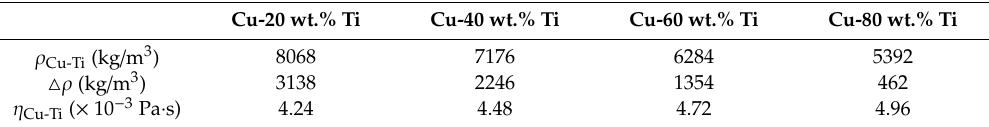
Table 1. The values of ρ Cu-Ti , (cid:52) ρ , and η Cu-Ti with di ff erent Cu-Ti proportions (e.g., “Cu-20 wt.% Ti” means the weight percentage of Ti in the Cu-Ti alloy is